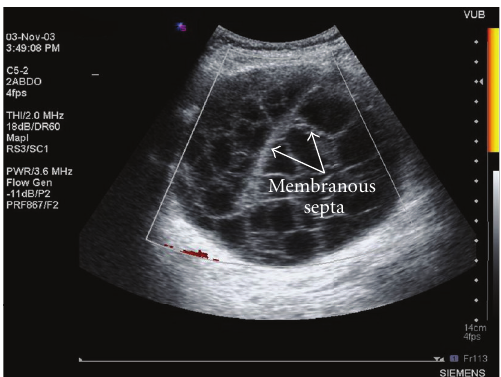
Figure 1: Abdominal ultrasonography (US) showing a well- defined large cystic mass in the right hypochondrium with several membranous septa (arrow).